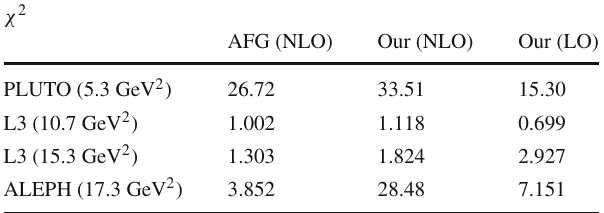
Table 3 χ 2 -values for Our results and the AFG results χ 2